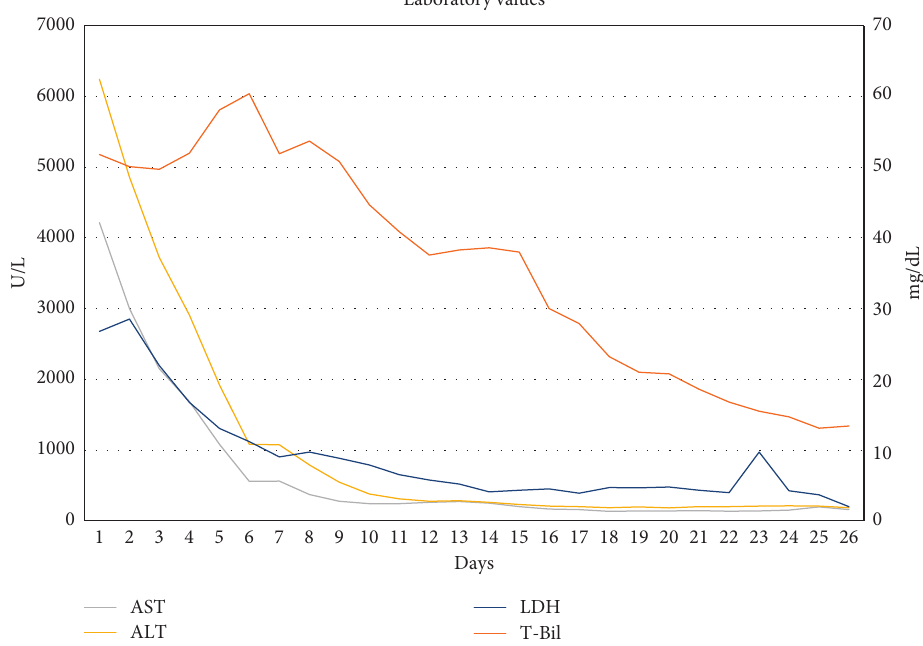
Figure 3: Changes in AST, ALT, LDH, and T-Bil during hospitalization are plotted from admission at days 1–25.